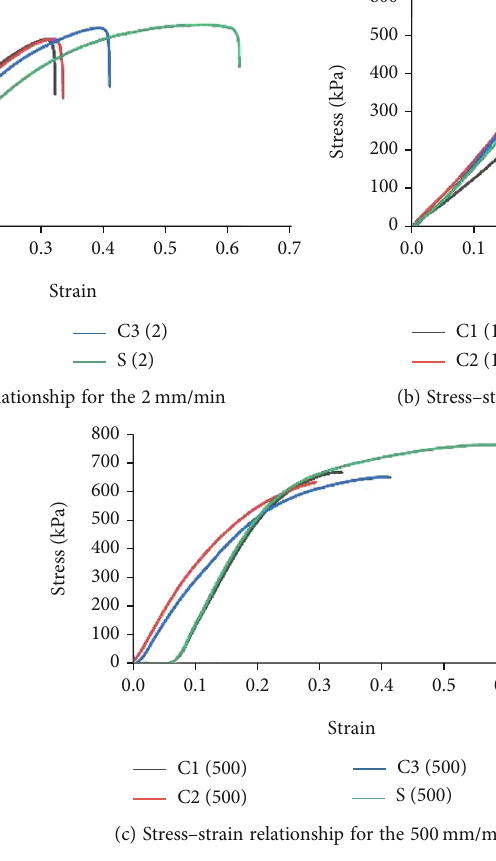
Figure 4: Stress – strain relationships corresponding to various strain